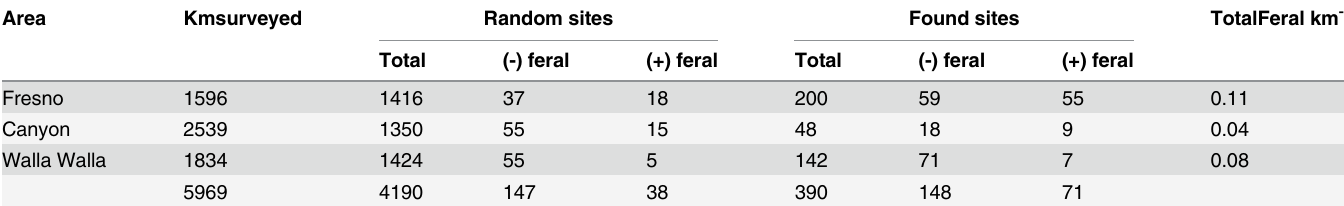
Table 3. Number of non-GE (-) and GE feral (+) populations observed at random and found sites in three study areas. Area Kmsurveyed